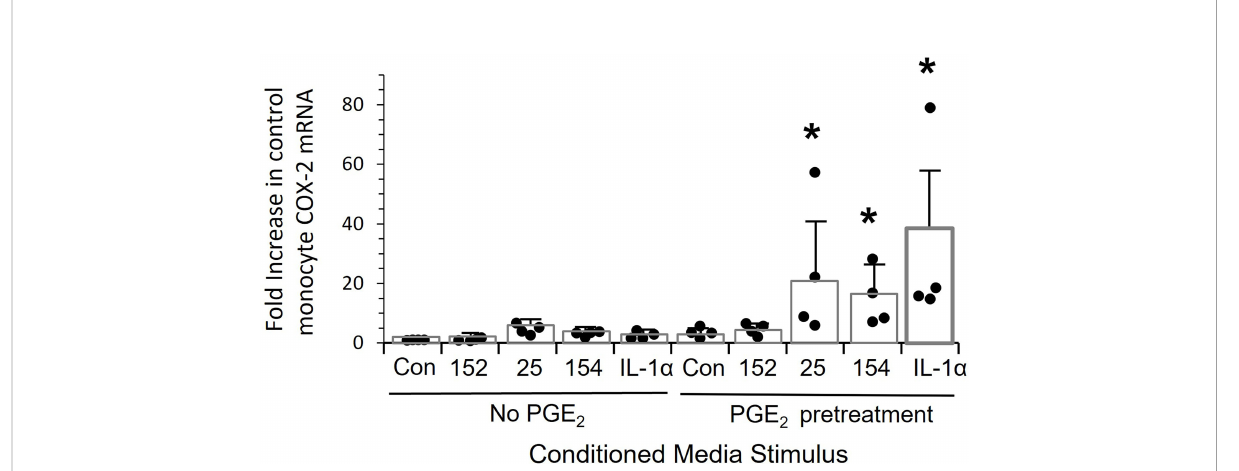
FIGURE 8 Pre-treatment of monocytes with PGE-2 increases the response to tumor line conditioned media and recombinant IL-1alpha. Control monocytes from four individuals were cultured for 20 hrs. ± 5,000 pg/mL PGE 2 , stimulated for 24 hrs with conditioned media from SCC152, SCC-25, SCC-154 or with 200 pg/mL IL-1 a , and COX-2 mRNA measured by RT-Q-PCR. Bars indicate mean +/- SD relative to untreated cells with no stimulation (Con.) Pre-treatment with PGE 2 signi fi cantly increased response to conditioned media from SCC25 and SCC154 and recombinant IL-1 a (p<0.03), but not the response to conditioned medium from SCC152.